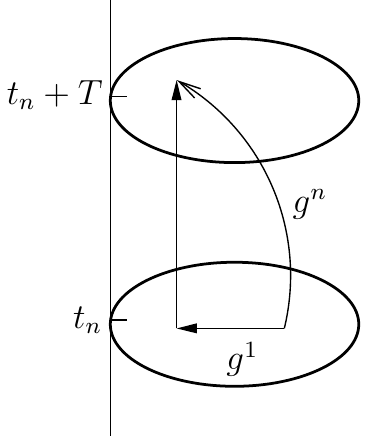
Fig. 1. Map at one period (after Arnold,